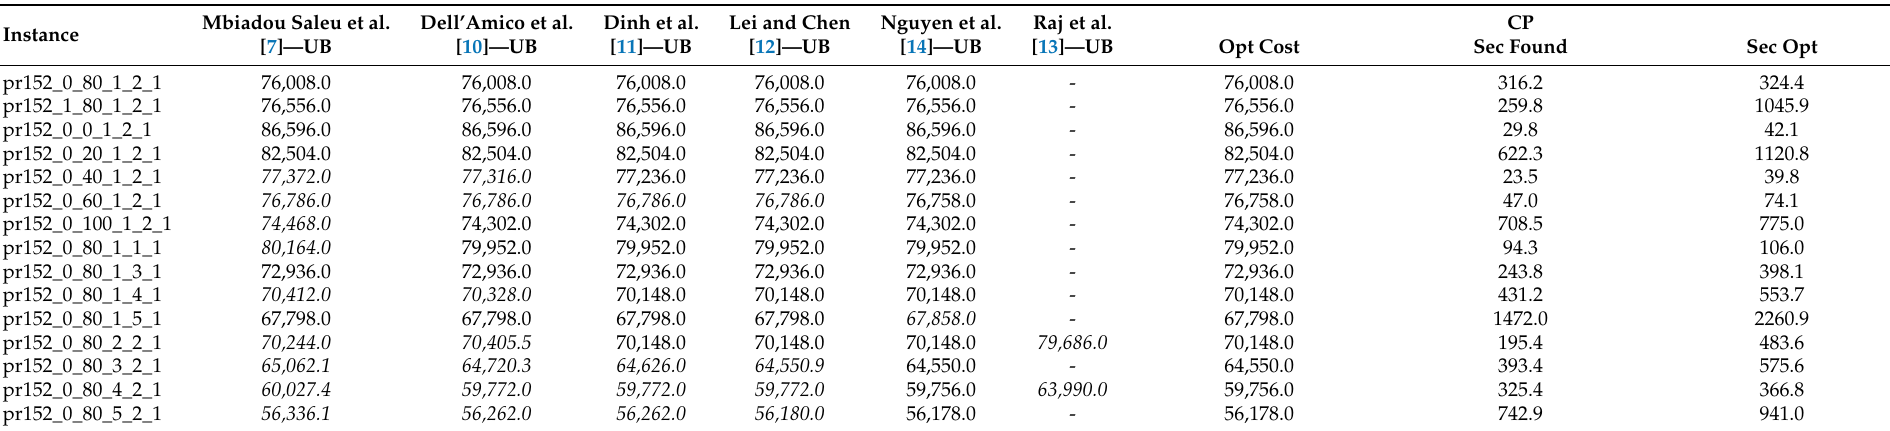
Table 6. Instances originated from pr152 in [7]. Optimal solution costs.